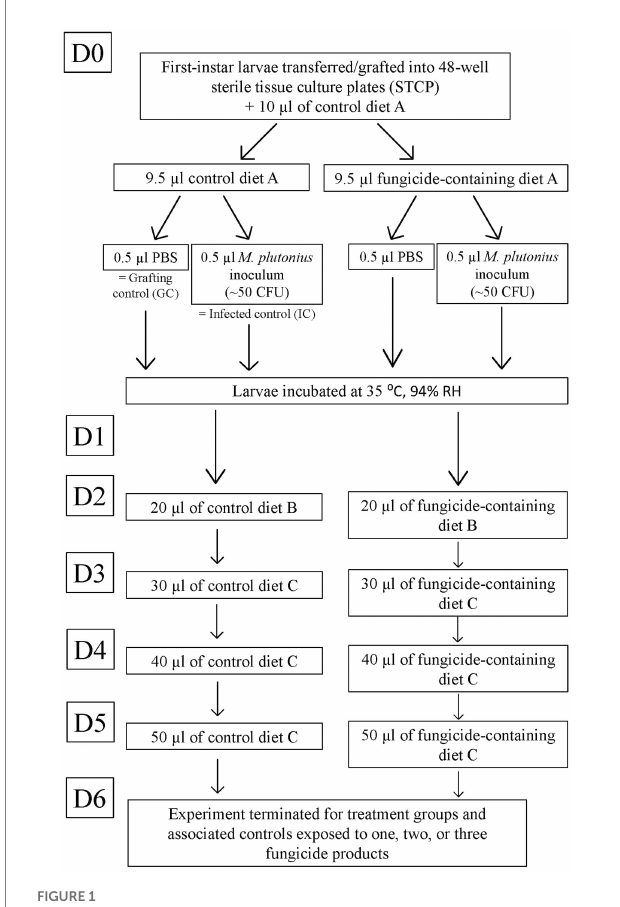
FIGURE 1 Diagram of experimental fungicide exposure and larval infection for larvae reared until day 6 (D6). Larvae exposed to one, two, or three fungicide products were reared for 6 days in vitro. The flow chart outlines timeline of infection and chronic fungicidal exposure. Larvae were monitored daily for survival.